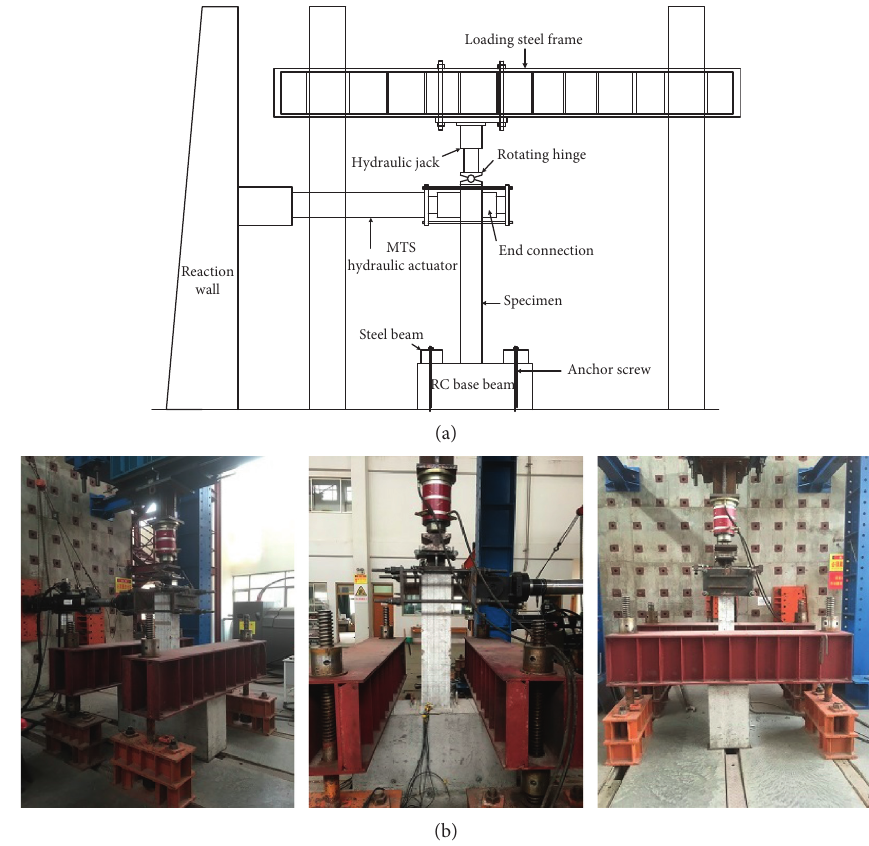
Figure 2: Test loading device. (a) Schematic diagram of test loading device. (b) Field test loading